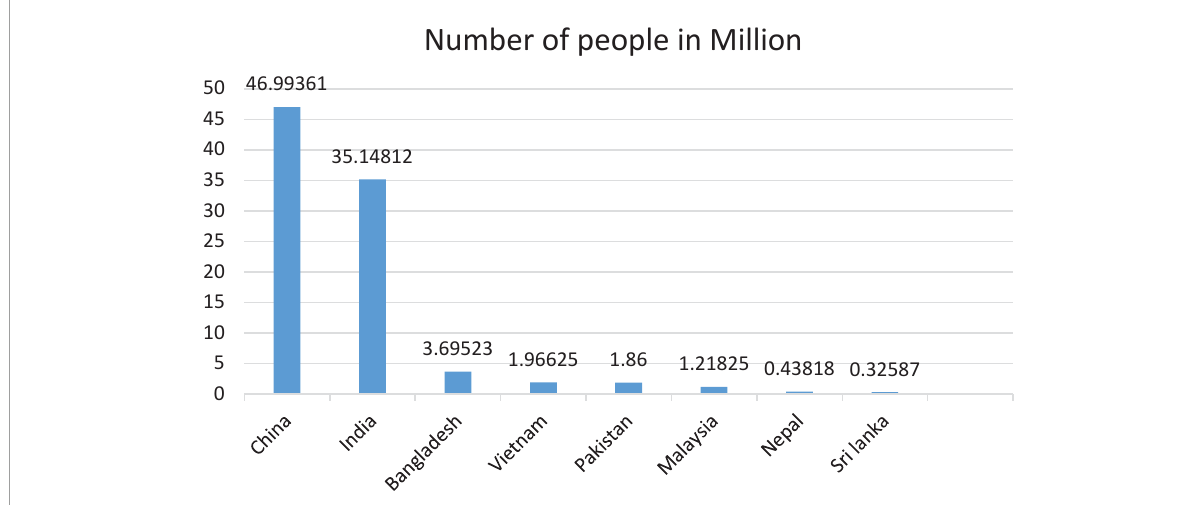
FIGURE1 Number of people enrolled in tertiary education in selected Asia-Pacific economies, 2019.